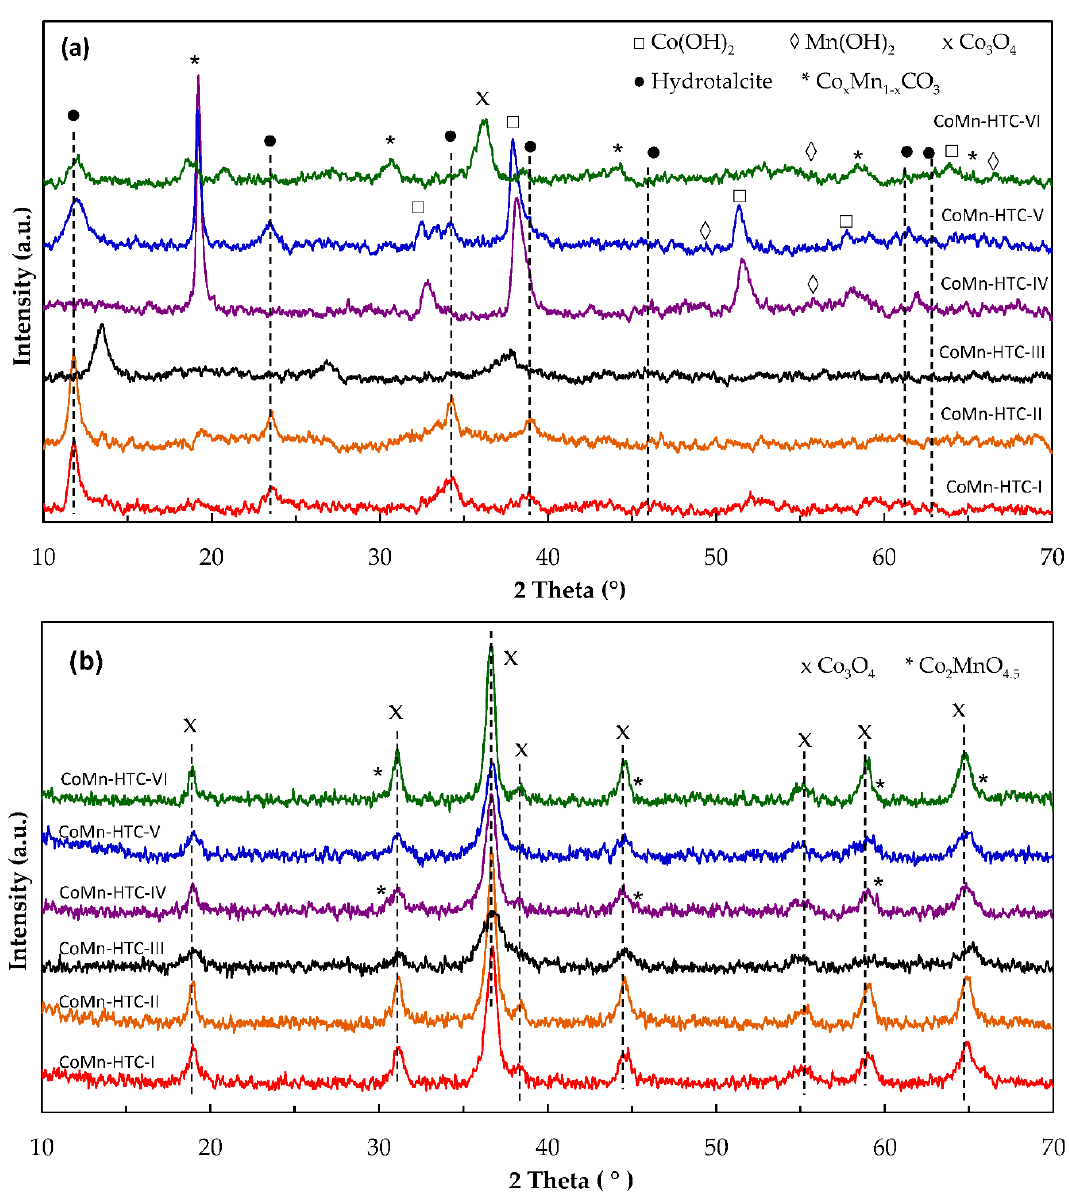
Figure 5. X-ray di ff raction (XRD) patterns of the ( a ) dried and ( b ) calcined CoMn-HTC Figure 5. X-ray diffraction (XRD) patterns of the ( a ) dried and ( b ) calcined CoMn-HTC catalysts. The CoMn-HTC-IV, CoMn-HTC-V, and CoMn-HTC-VI catalysts had no clear layered structure